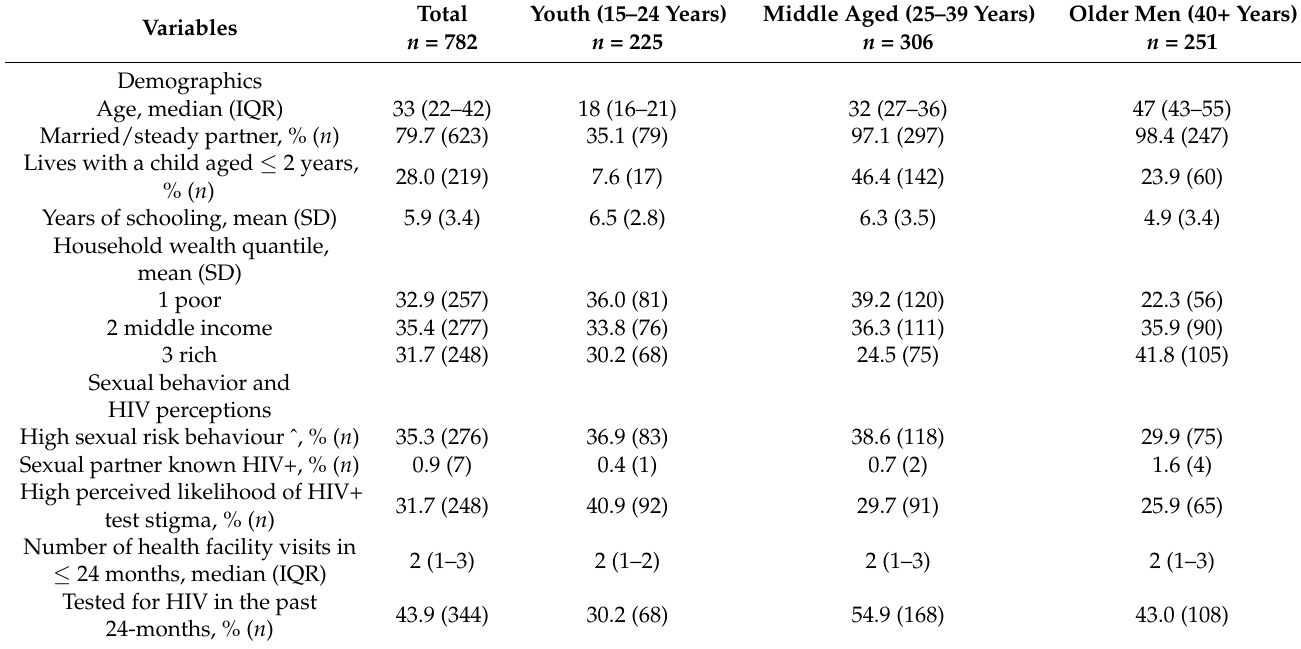
Table 1. Socio-demographic features of men who attended an OPD visit in the past 24-months and were eligible for HIV testing ( n = 782).